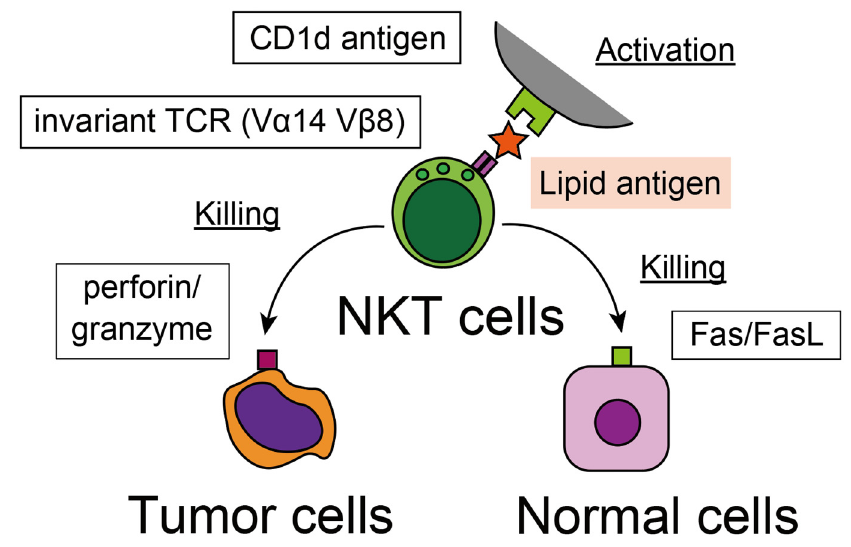
Figure 2. NKT cells recognize lipid-related antigens expressed on CD1d